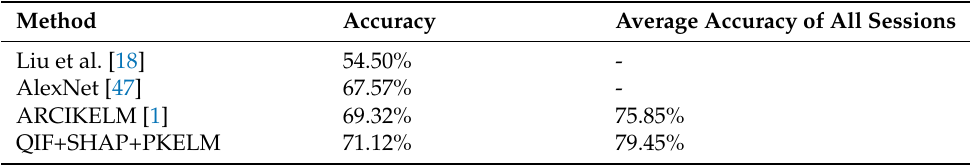
Table 9. Summary of research using deep feature extraction and fine-tuning to classify the UEC- FOOD256 dataset.